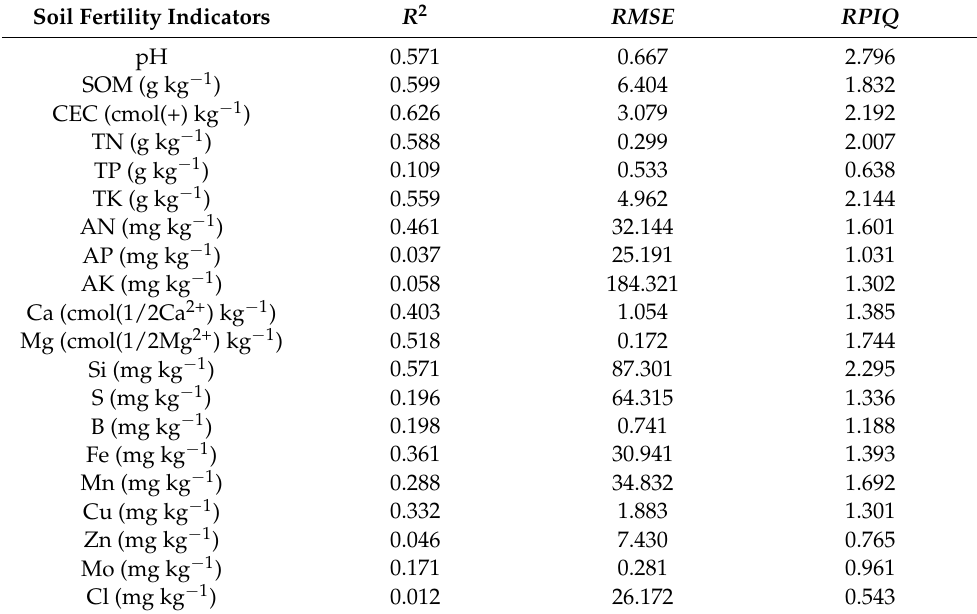
Table 4. Prediction accuracy of soil fertility indicators by PLSR